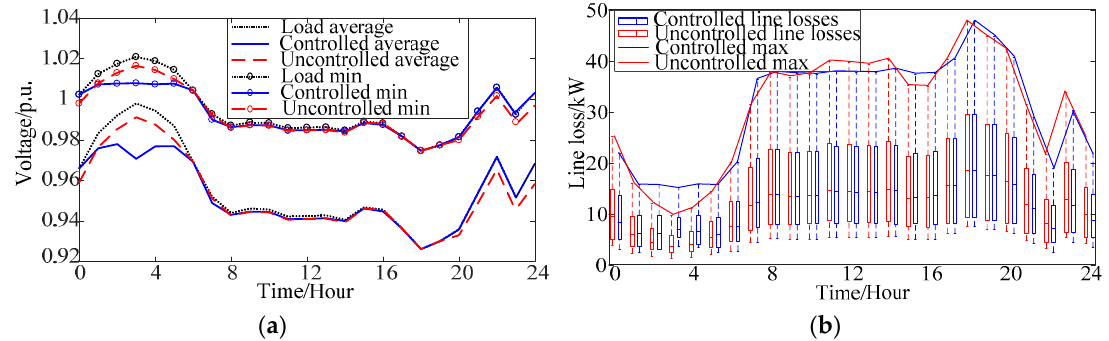
Figure 4. Power load profiles in the distribution network with renewable energy sources: ( a ) Load profiles of 123-bus power network; ( b ) EV charging load with and without control. minimized the objective function.